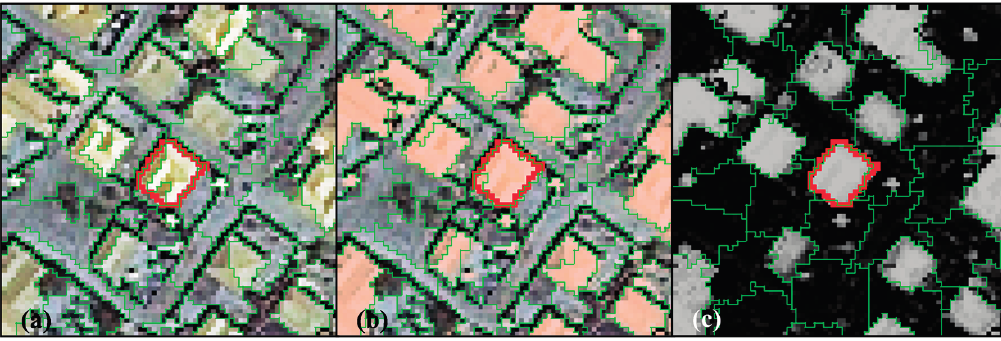
Figure 7. Segmented subsets, generated with the MS algorithm using the ( a ) original image, and a ( b ) Hybrid:CP image and segments generated with SLIC using a ( c ) probability